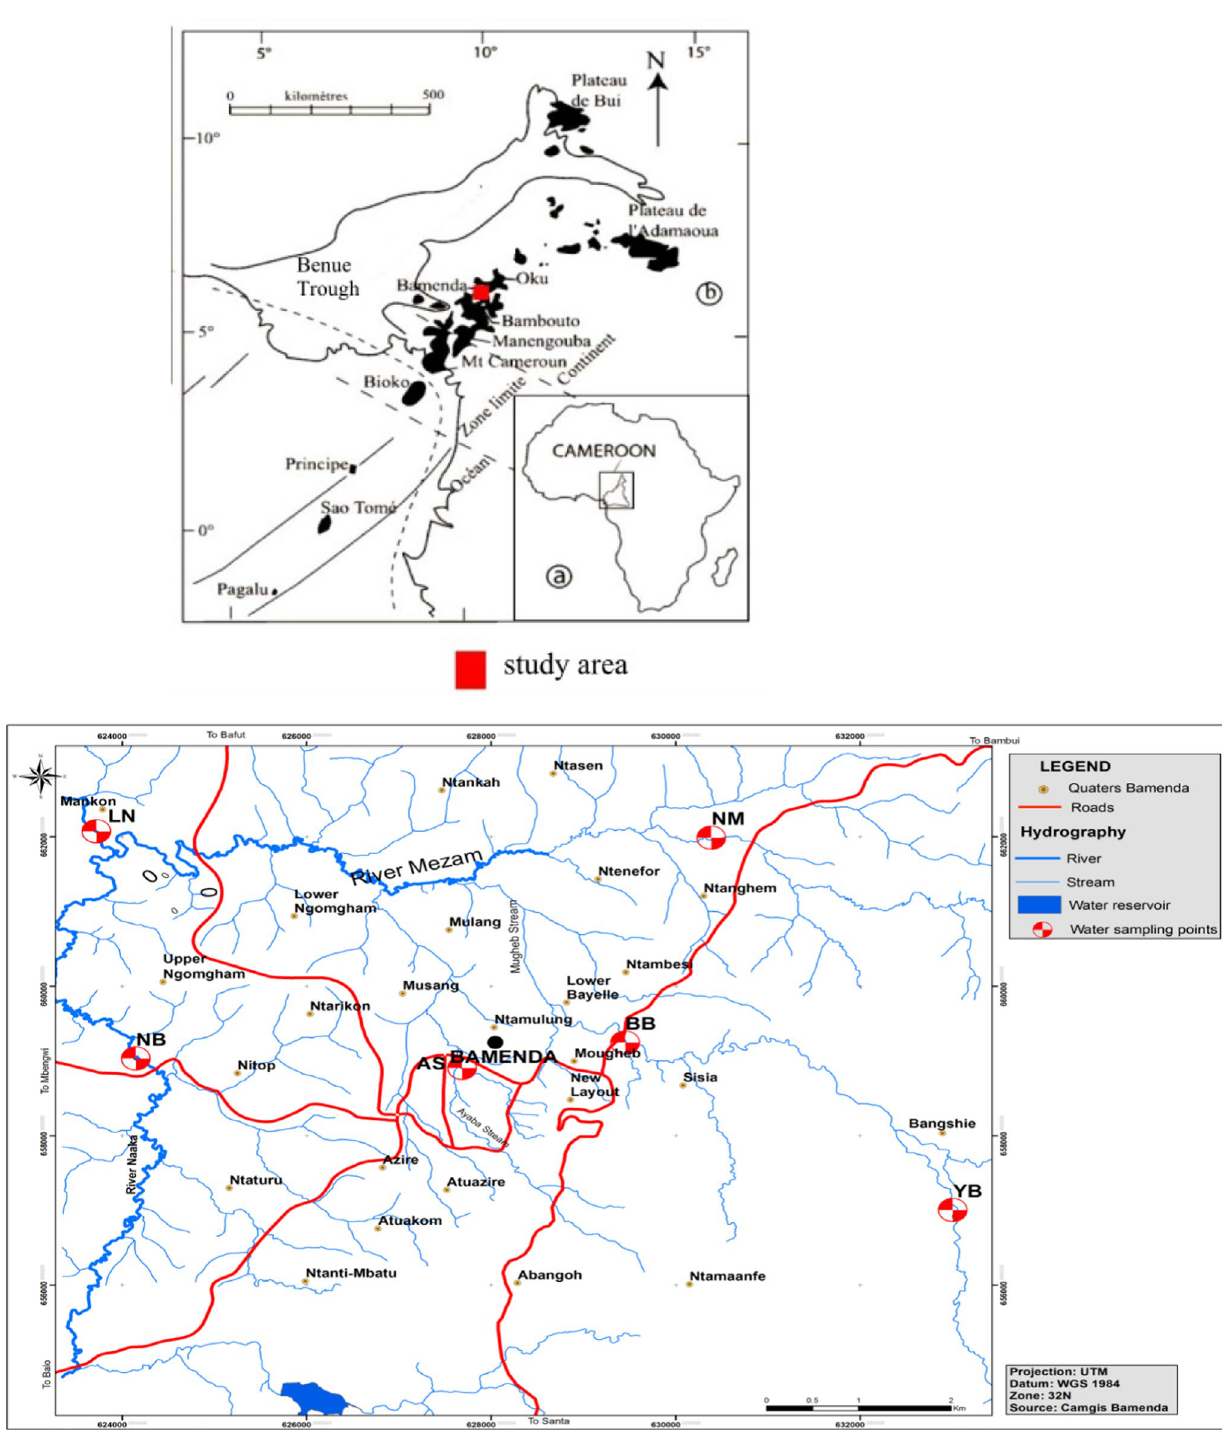
Fig. 1 Geology and location of sampling points in the study at YB and the highest values at LN (Fig. 2a). The mean pH values of the Mezam River water range from 5.85 in May to 6.53 in October (Table 2). Seasonal variations are not eminent, with highest values measured in October at NB and